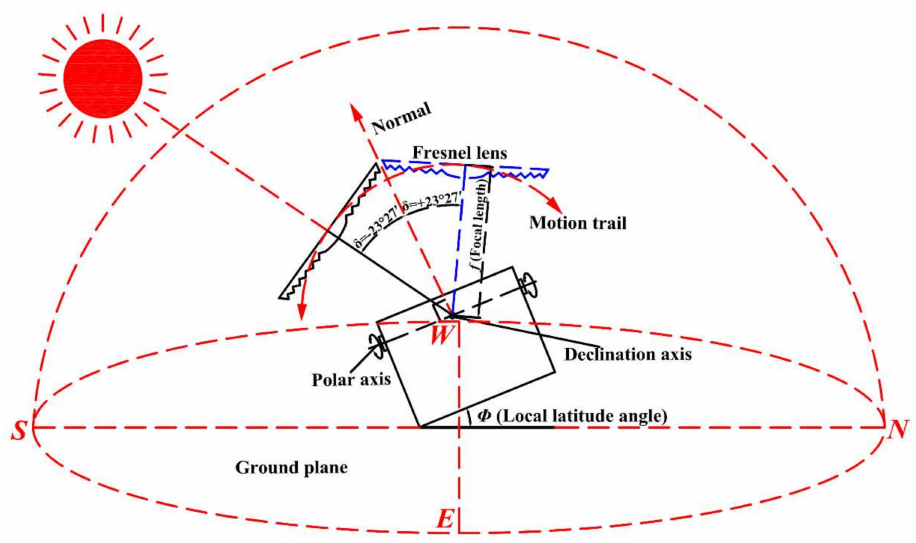
Figure 1. Schematic diagram of a fixed-focus Fresnel lens solar